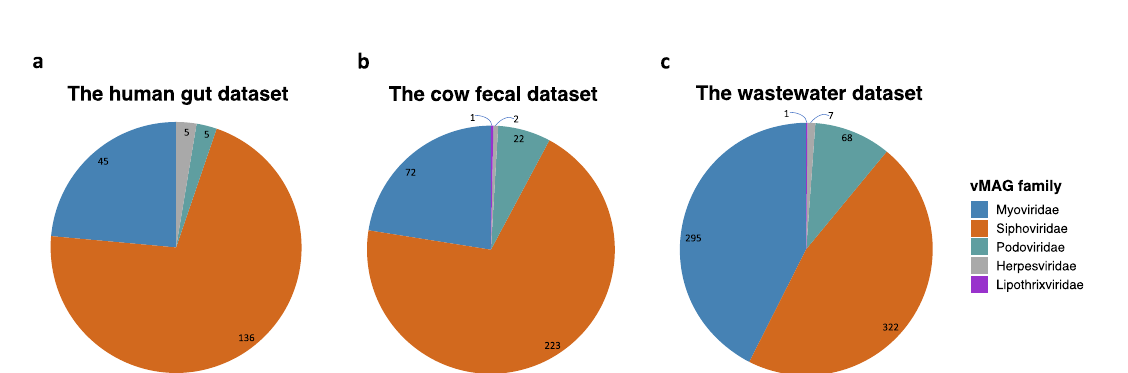
contig index as the axis unit. The vMAGs were fi rst ranked by their numbers of contigsandthenthecontigswithineachvMAGwererankedbytheirsizes.Thescale bar shows the number of raw Hi-C contacts between viral contigs.